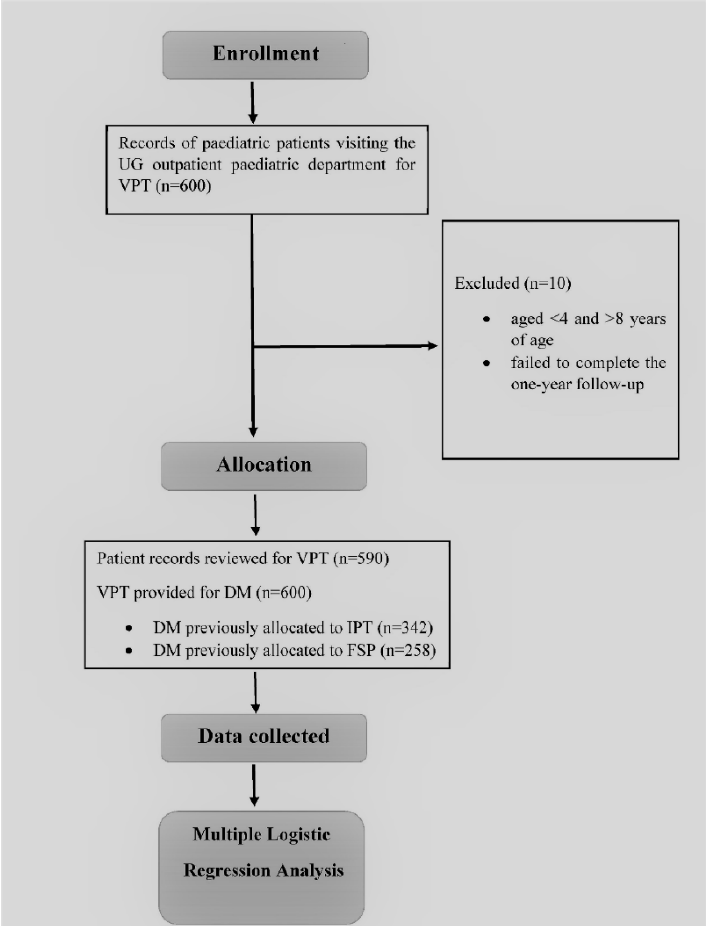
Figure 1. Flowchart of the study. Undergraduate (UG), Vital pulp therapy (VPT), Deciduous molar (DM), Indirect pulp therapy (IPT), Ferric sulfate pulpotomy (FSP).